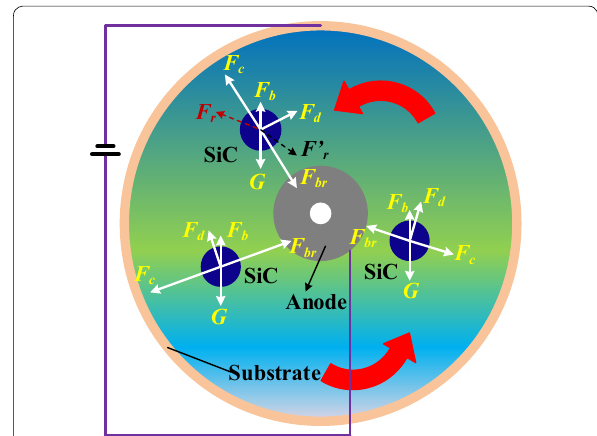
Figure 1 Force analysis of SiC at different positions under a supergravity